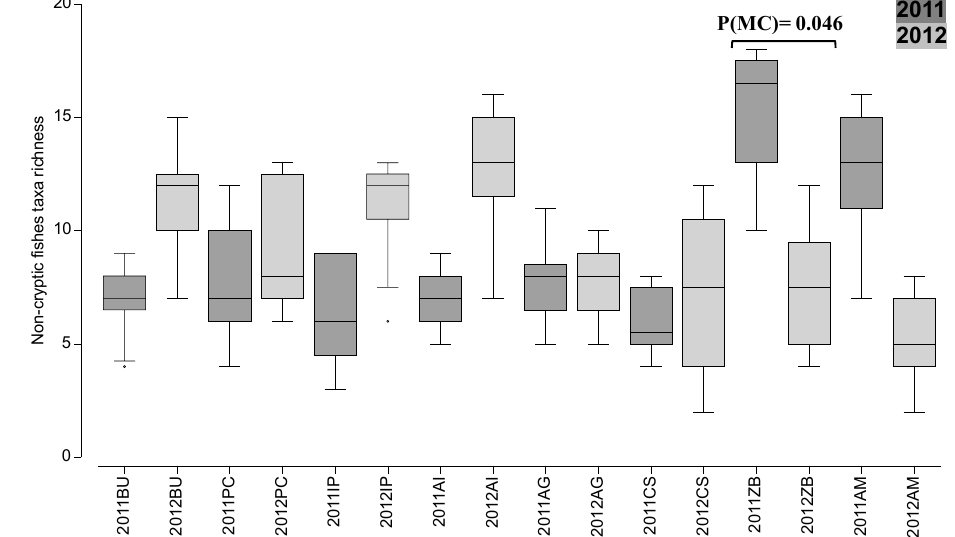
Figure 3. Non-cryptic fishes’ spatial-temporal variation of taxa richness (boxplot) in 2011 and 2012 in partially protected areas (“Ilha do Pessegueiro” (IP) and “Cabo Sardão” (CS)) and adjacent control areas (complementary protection areas; Burrinho (BU), Porto Covo (PC), Aivados (AI), Almograve (AG), Zambujeira (ZB), and Am á lia (AM)) of the northern marine PNSACV. Pairwise tests showed significant differences between years in ZB, as